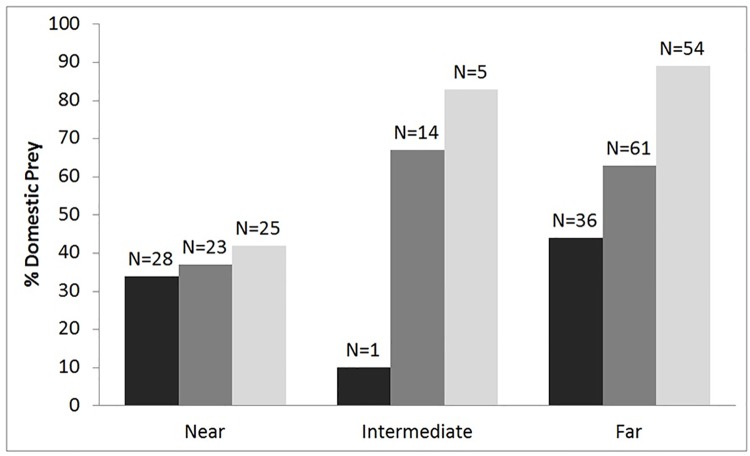
Percentage of domestic animals killed by tigers during the summer (black bars), rainy (dark grey bars), and winter (light grey bars) seasons with increasing distance from the core zone.The proportion of domestic animals killed doubled at >2 km distance from the core during the rainy and winter seasons (df = 4, p = 0.006), but remained low during the summer.